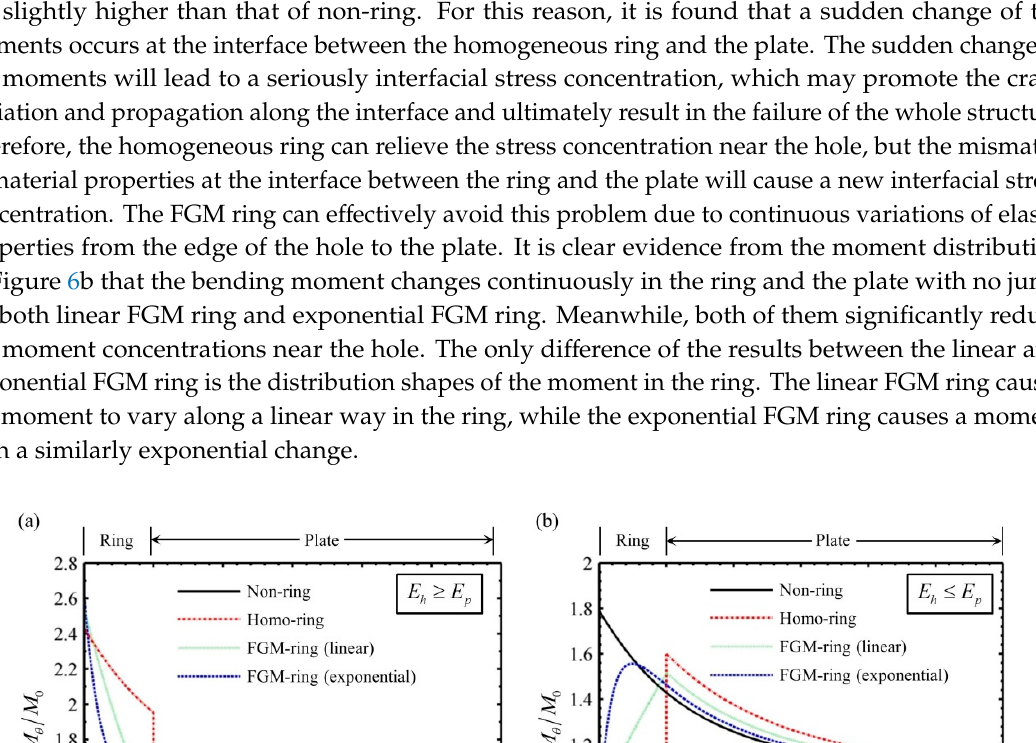
0 = 90 θ ± ) for different types